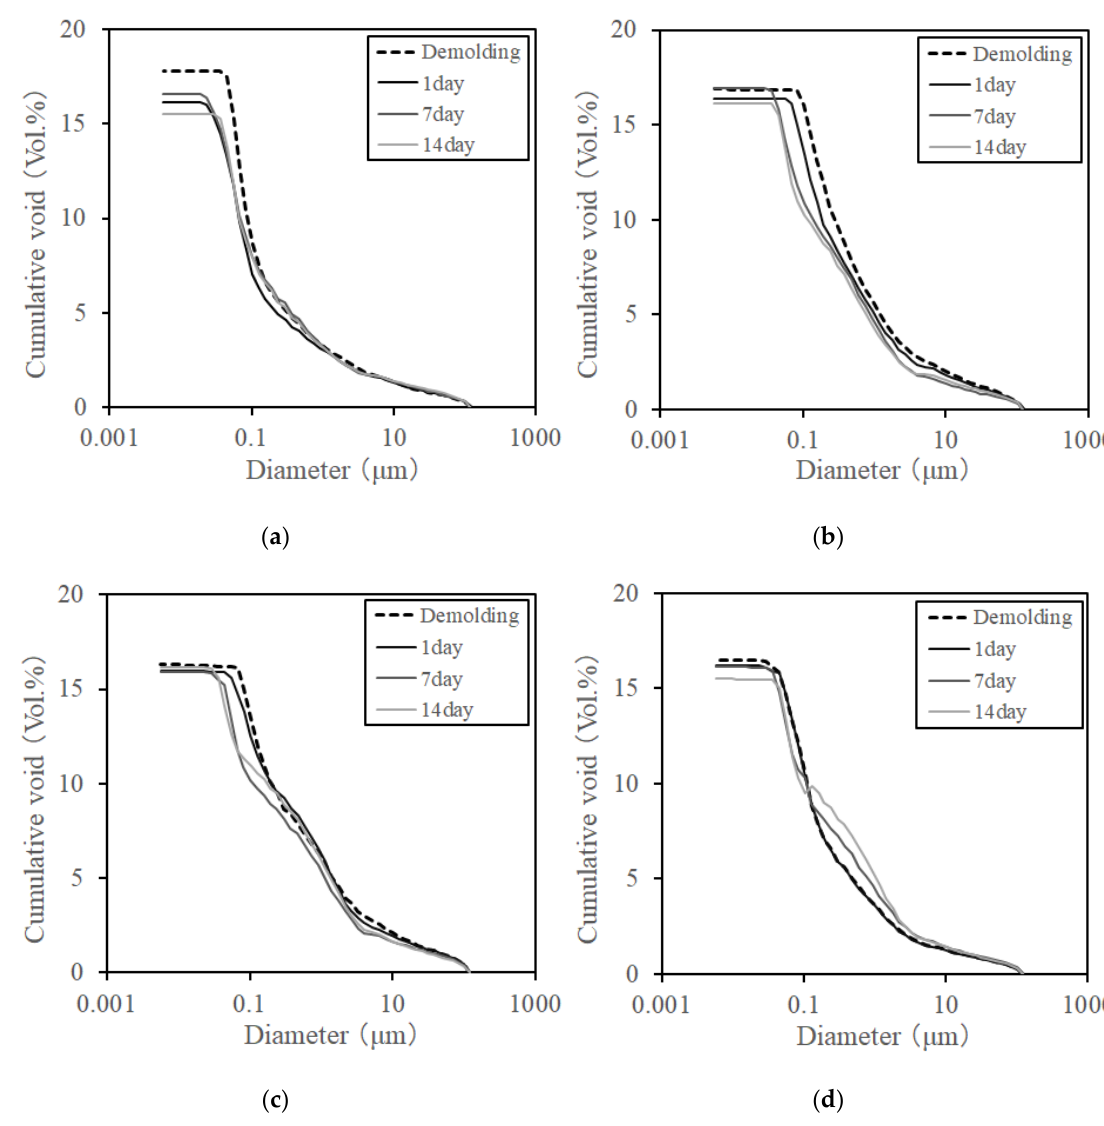
Figure 15. Cumulative porosity of concrete. ( a ) Steam curing, ( b ) MW1, ( c ) MW2, ( d ) MW3.